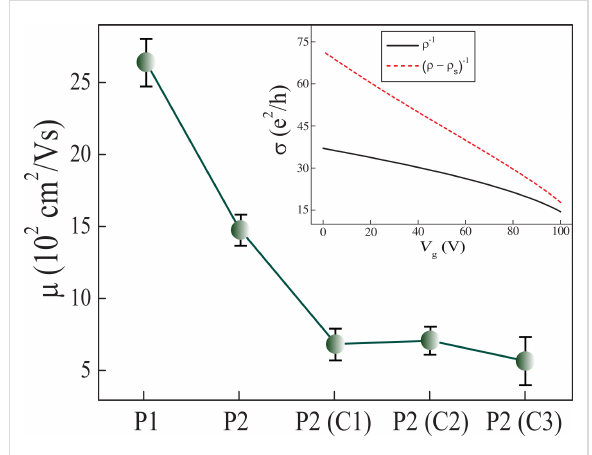
Figure 6: Hole-mobility values of graphene devices fabricated by dif- ferent procedures, P1 and P2, and by different cleaning methods, C1, C2 and C3. Inset: graphene conductivity ρ − 1 and ( ρ − ρ s ) − 1 as a func- tion of V g for a representative device produced by procedure